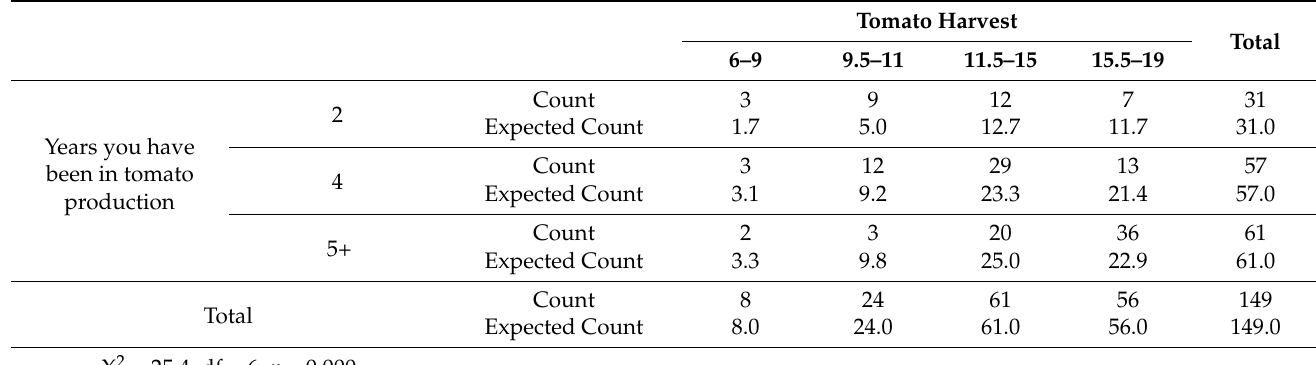
Table 6. Tomato farming experience in years. Tomato harvest crosstabulation.